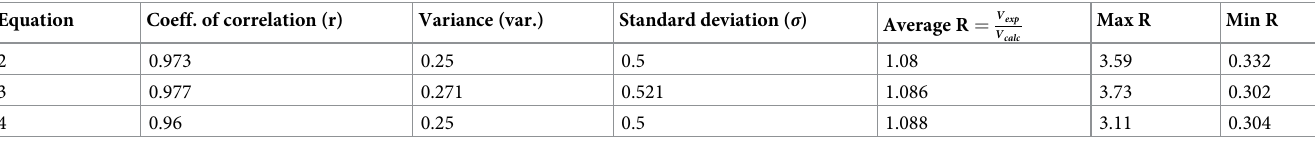
Table 1. Statistical results used in Eqs